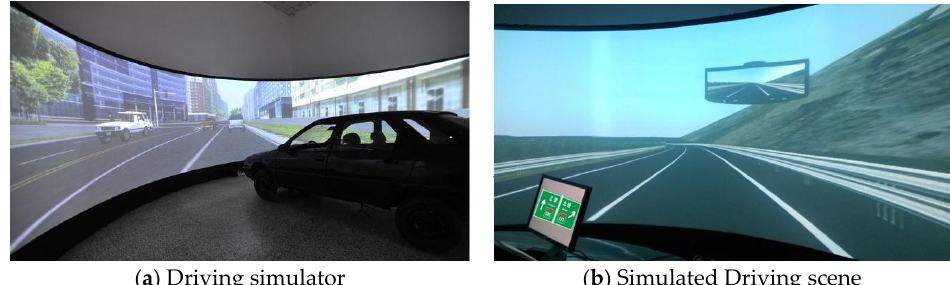
Figure 6. Driving simulator and a scene.